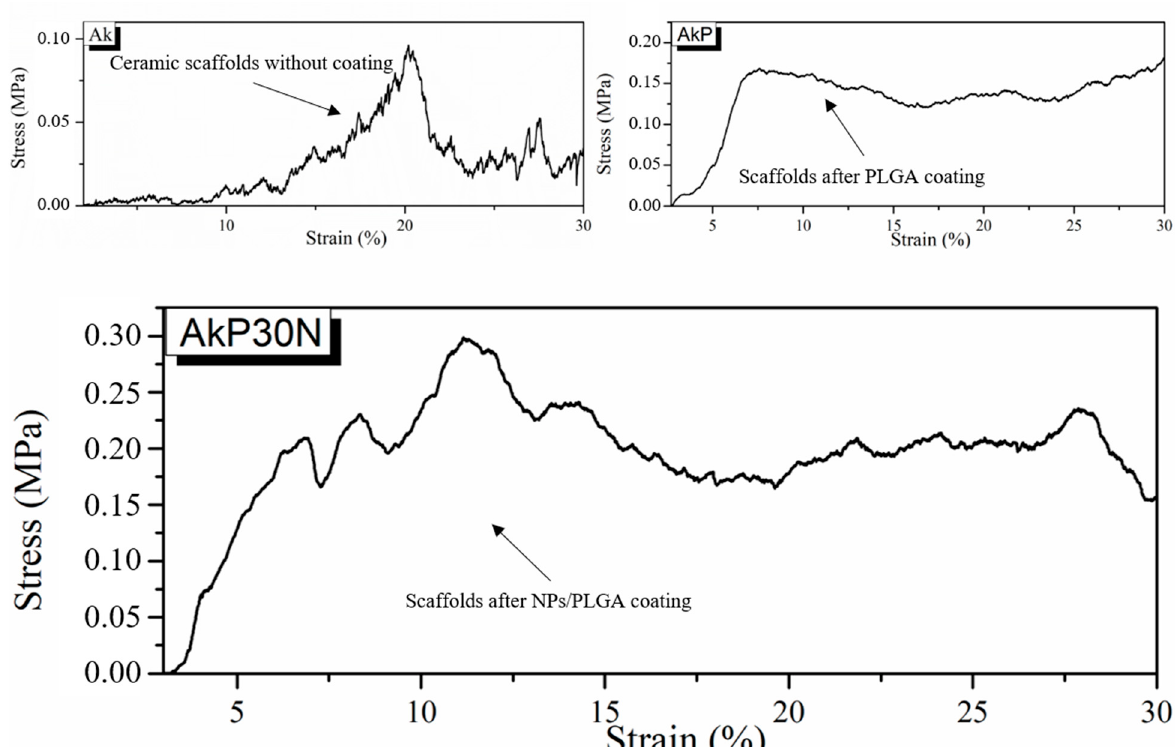
Figure 15 . Indicative stress — strain (%) curves of the developed scaffolds.